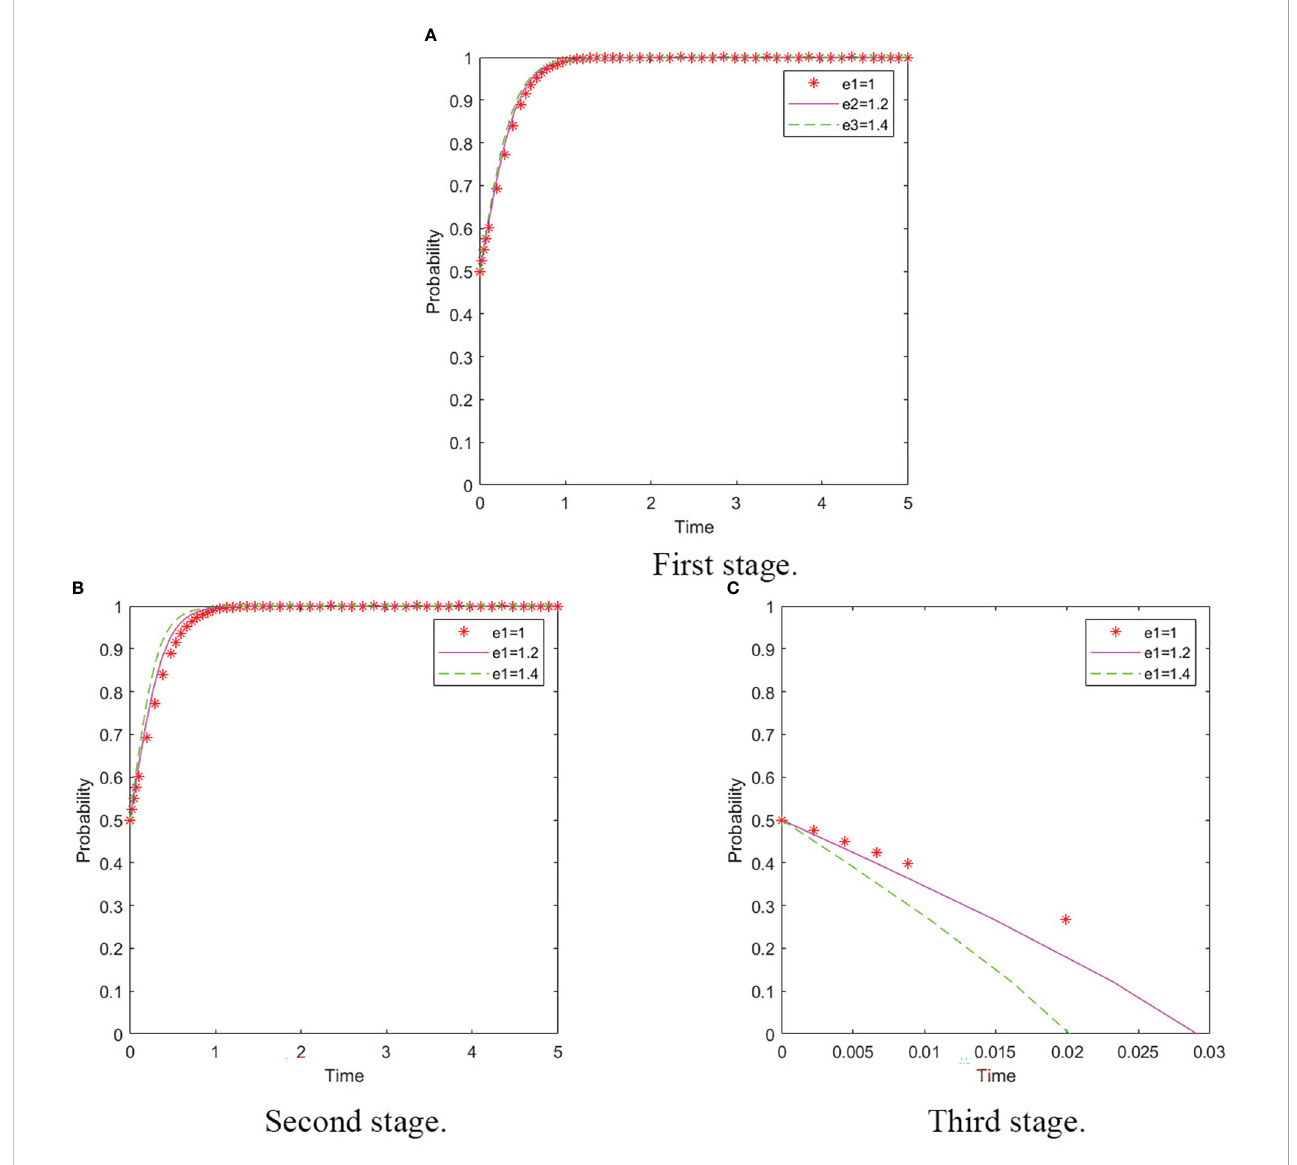
FIGURE 8 Changing the evolutionary path of the carbon revenue coef fi